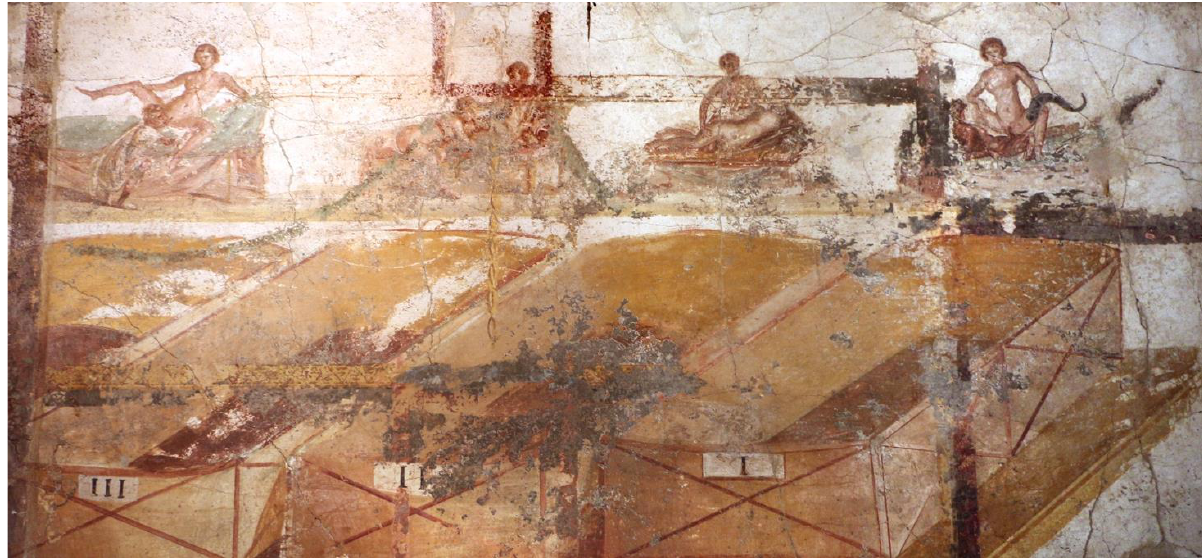
Figure 14. Erotic frescoes of the Apodyterium in the Thermal